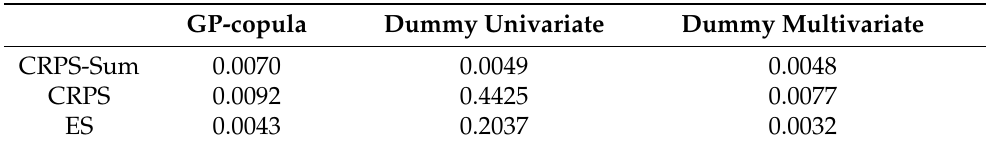
compares their performance with GP-copula based on CRPS-Sum, CRPS, and ES. It shows that CRPS-Sum dummy models have better performance in comparison to